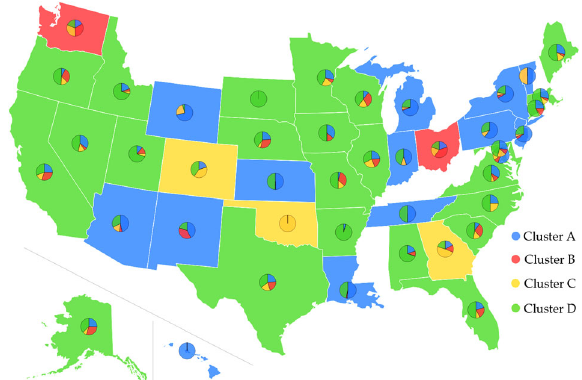
Fig. 1 Pie chart plot of four clusters in the United States as of 11 September 2020. The blue, red, yellow, and green colors represent clusters A, B, C, and D, respectively. The base color of each state is decided by its dominant cluster. No color is assigned to a state if we cannot fi nd its complete genome sequences at the GISAID